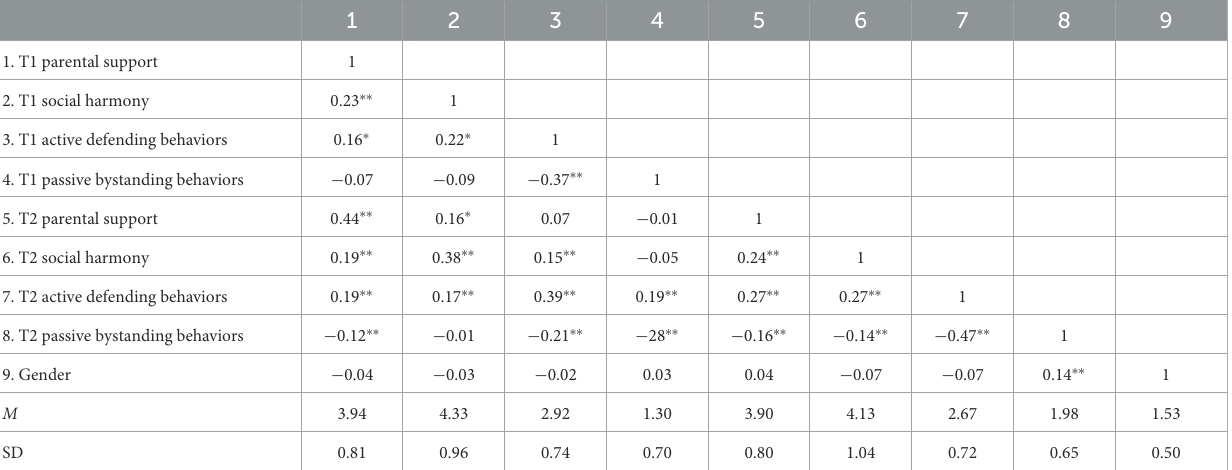
TABLE 1 Descriptive statistics and correlations ( N = 445).